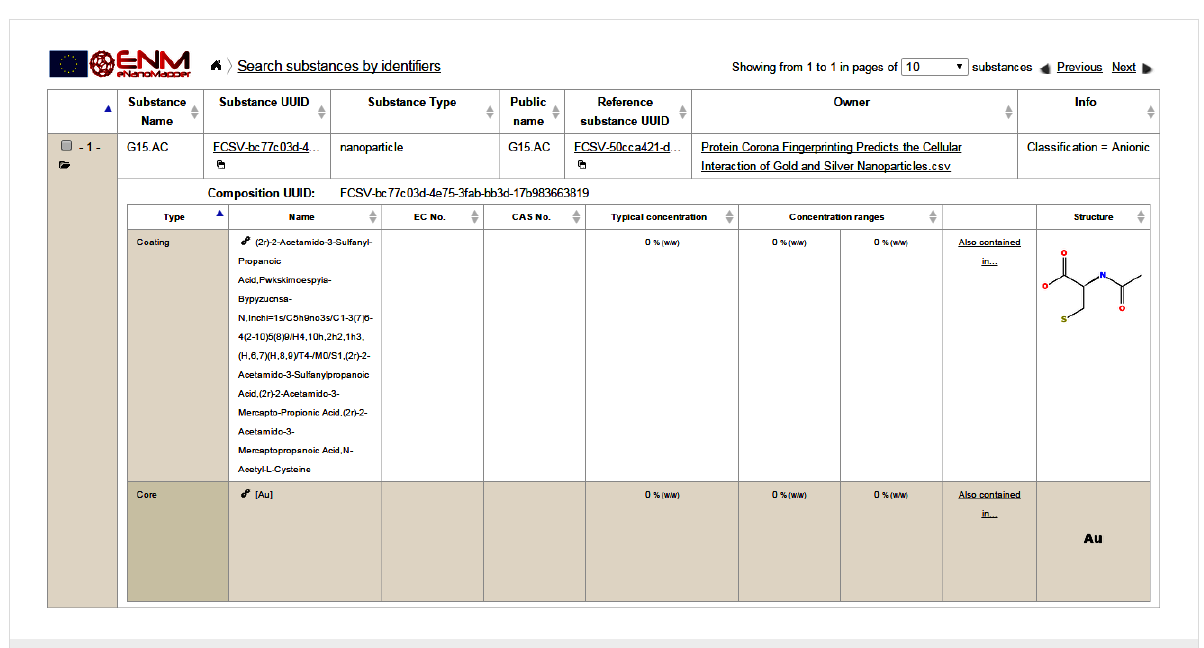
Figure 3: Screenshot showing a nanomaterial entry (a gold nanoparticle with the name G15.AC) and its components (a gold core and organic coating). The components can be retrieved through the “/substance/{uuid}/composition” API call and are linked to the OpenTox API compound resources, which allows for the execution of chemical structure based calculations and predictions. This NM entry is part of the the Protein Corona dataset described below and was imported via a spreadsheet (.csv) file. The “reference substance UUID” refers to the chemical structure, which is considered the main component (Au in this case). The “Owner” column typically refers to the NM manufacturer, or if such information is missing it refers to the data file used for import. The “Info” column may contain an arbitrary key-value data, typically referring to the NM identifiers in other